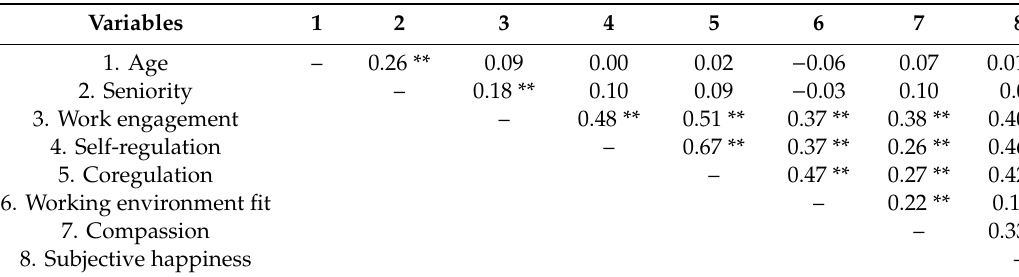
Table 2. Bivariate correlations between variables.